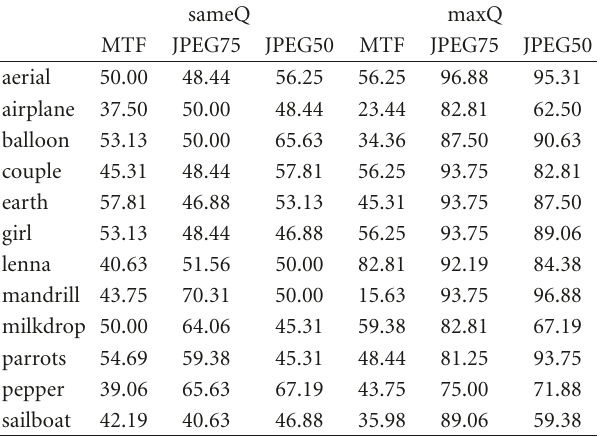
Table 6: Extraction rates in JPEG compression of quality 75%.